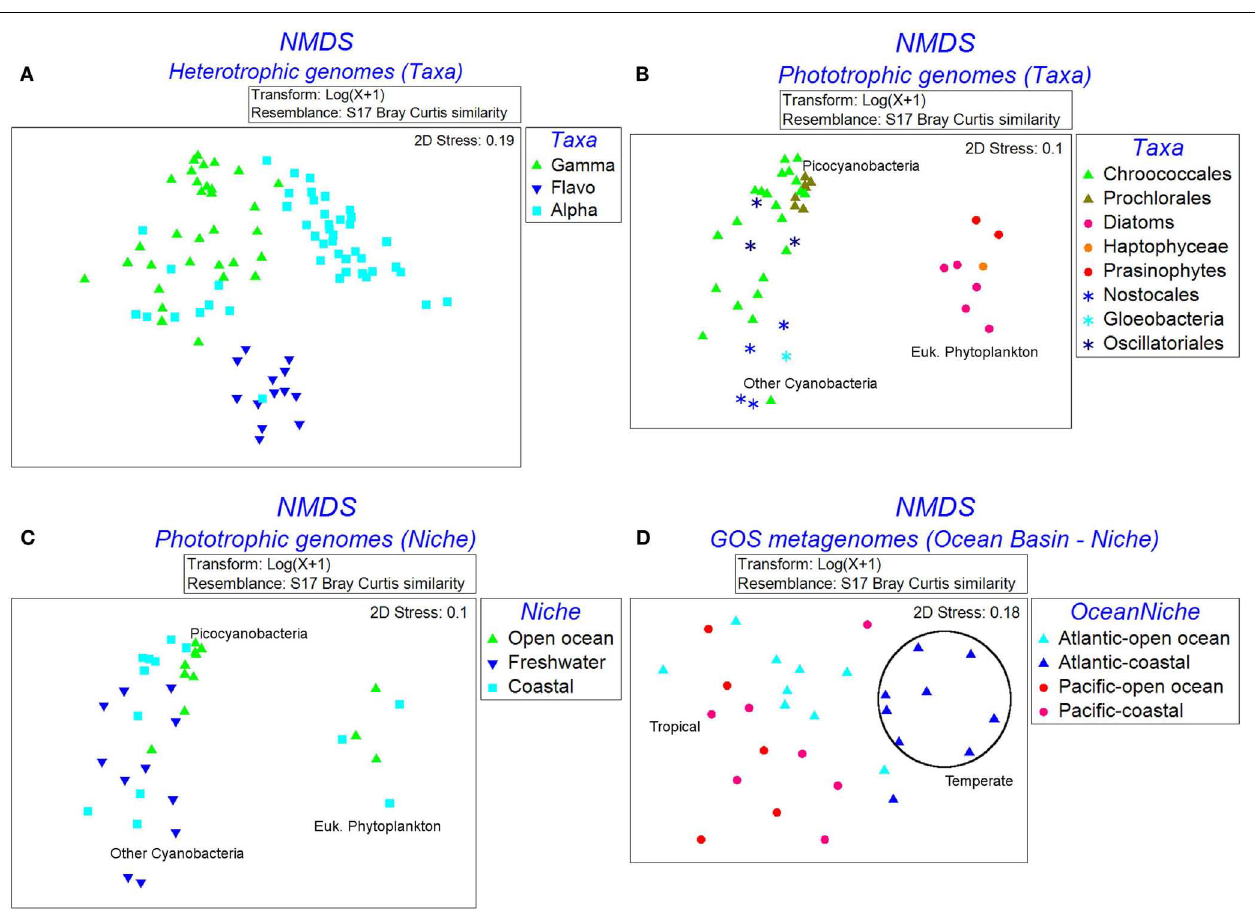
labeled by taxa, (B) phototrophic genomes labeled by taxa, (C) phototrophic genomes labeled by niche, and (D) GOS metagenomes labeled by marine niche